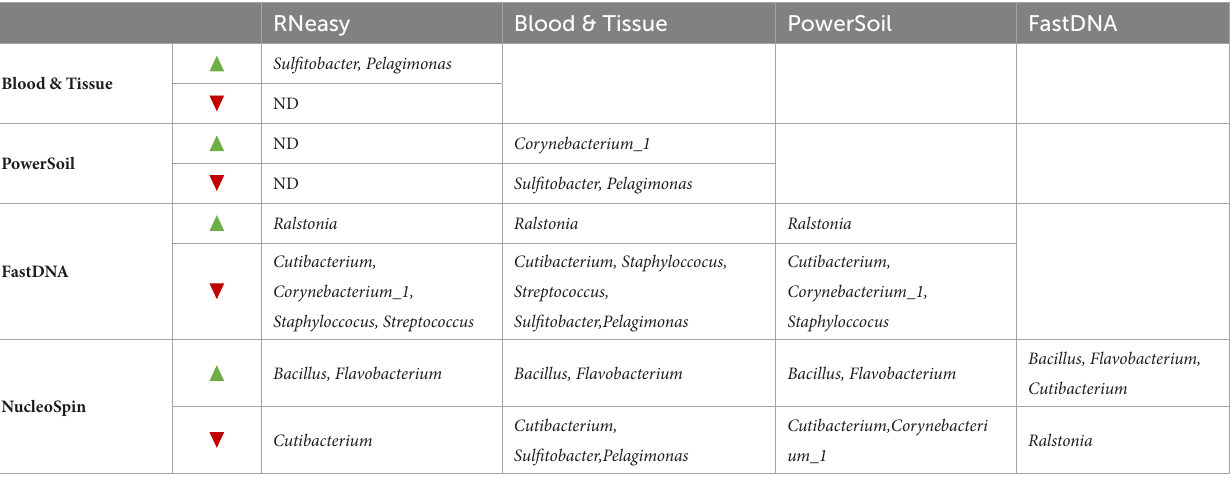
TABLE 1 Discriminating genera, derived from LefSe analysis.